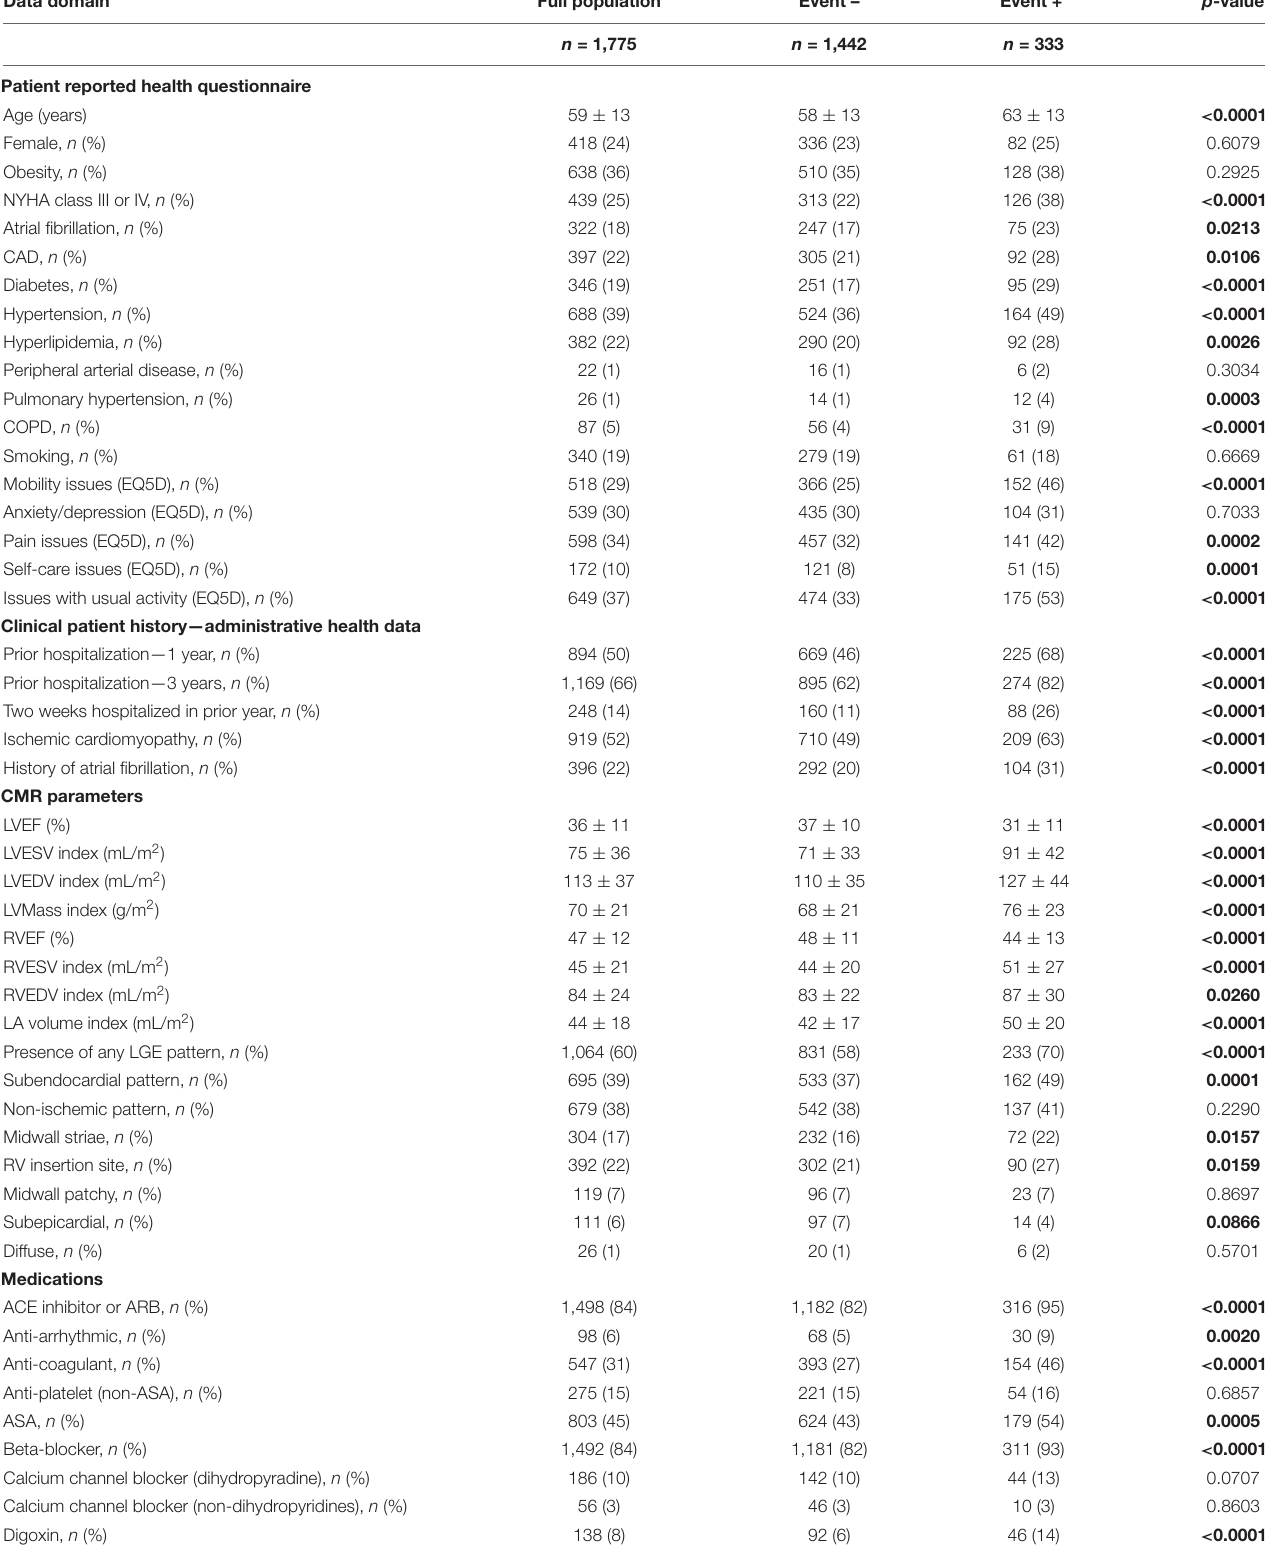
TABLE 1 | Baseline clinical and CMR characteristics of the study